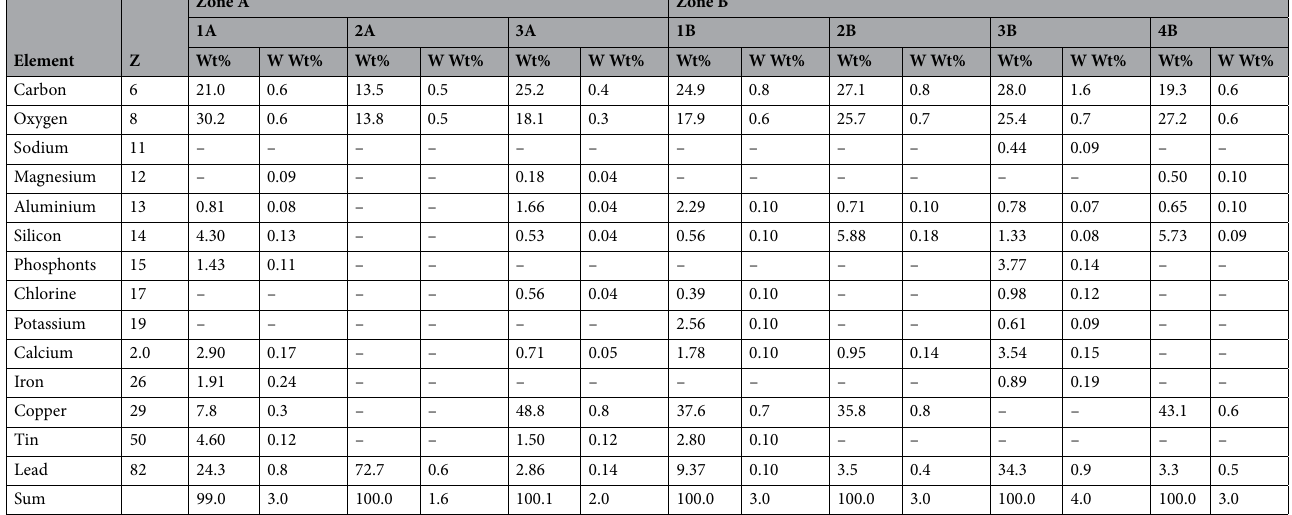
Table 2. Elemental composition of the sampling points of Zone A and Zone B of inclusion #2 mapped in Fig. 5a. Data collected with